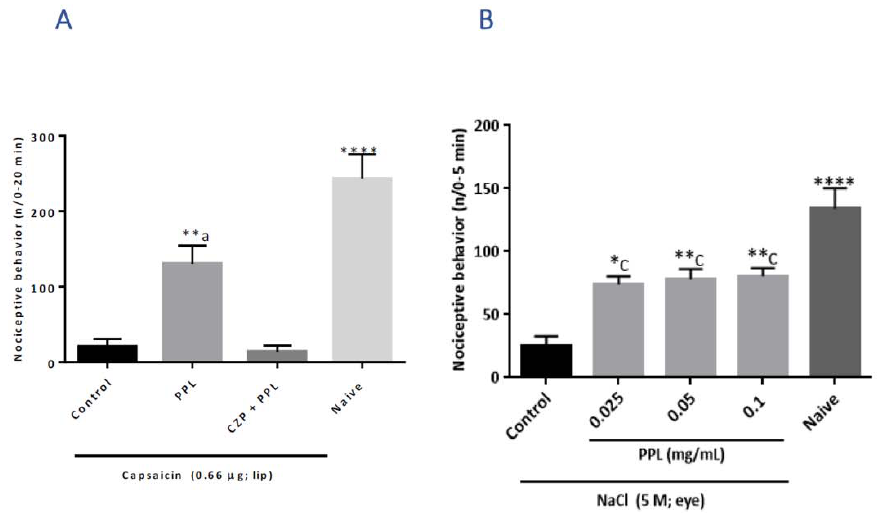
Figure 2. Effect of PPL on capsaicin-induced orofacial nociception ( A ) and on hypertonic saline-induced corneal nociception ( B ) in adult zebrafish. The results are expressed as mean values ± standard error of the number of nociceptive behaviours for each group. ANOVA followed by Tukey test. * p < 0.05, ** p < 0.01 vs Control; **** p < 0.0001 vs Control and CZP+PPL; a p < 0.01 vs CZP+PPL and Naive; c p < 0.01 vs Naive. CZP = capsazepine; PPL = 0.05 mg/mL PPL. According to Figure 3, the depletion of TRPV1+ C-fibres by capsaicin decreased the glutamate-induced orofacial nociceptive activity (**** p < 0.001 vs control) and abolished the antinociceptive effect of PPL (0.025 mg/mL).